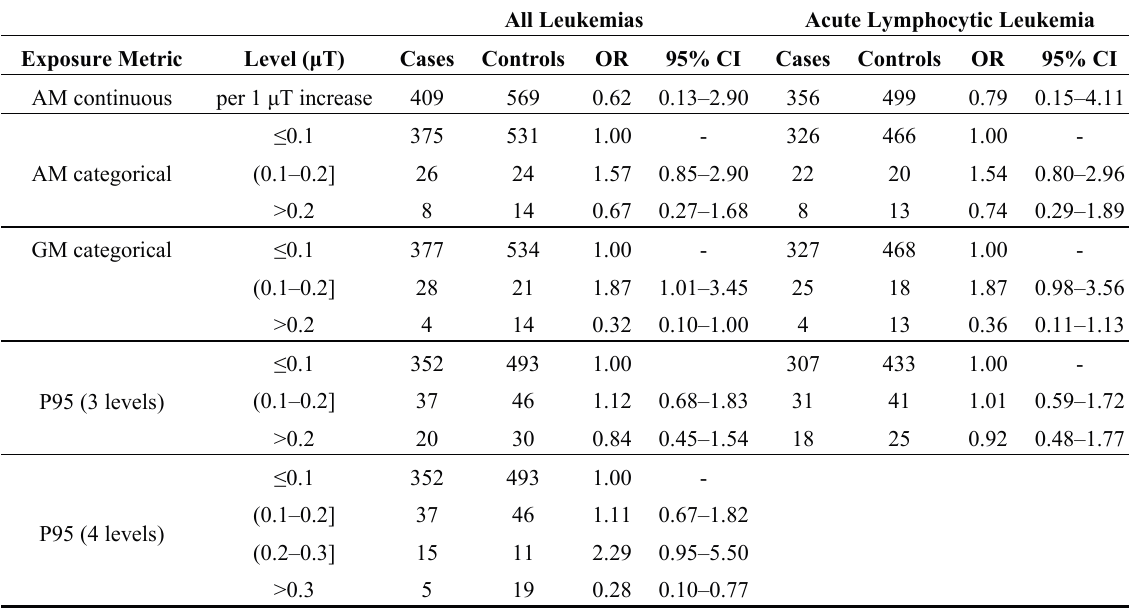
Table 6. ORs for childhood leukemia according to nighttime § ELF-MF exposure (CLR—Adjusted * ). All Leukemias Acute Lymphocytic Leukemia Exposure Metric Level ( μ T) Cases Controls OR 95% CI AM continuous